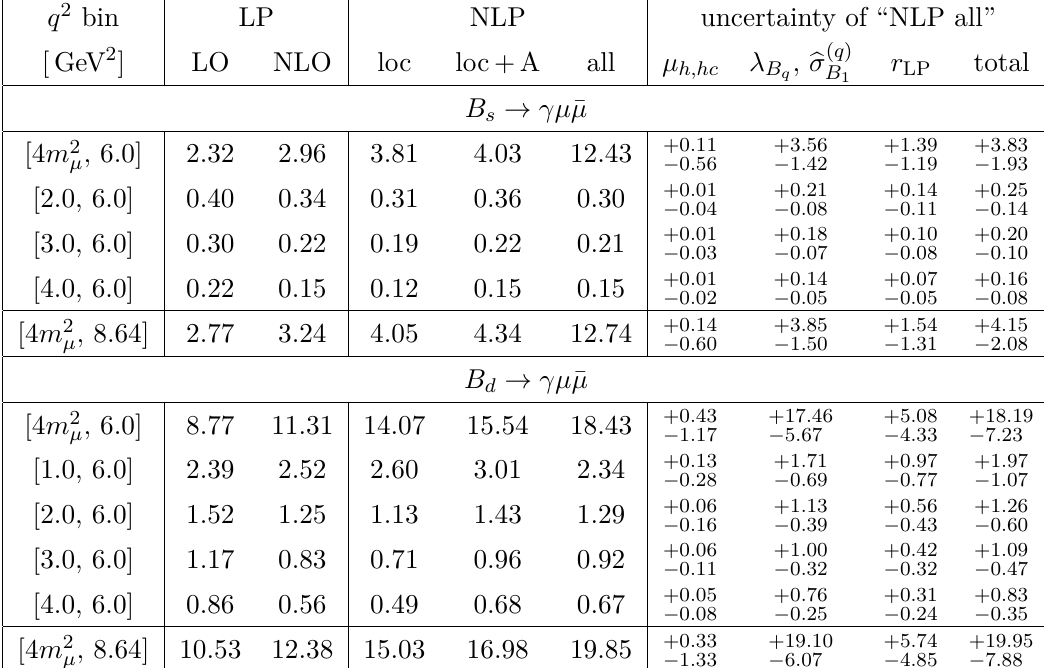
Table 3 . The q 2 -integrated branching fractions 10 9 × B ( B s → γµ ¯ µ ) and 10 11 × B ( B d → γµ ¯ µ ) in four / five bins in the various approximations shown in figure 9. “NLP all” corresponds to “NLP loc + A + B” in figure 9. The last four columns list the uncertainties due to 1) renormalization scale uncertainties, 2) B -meson LCDA parameters and 3) the continuum fraction r LP as well as “total” when adding them in